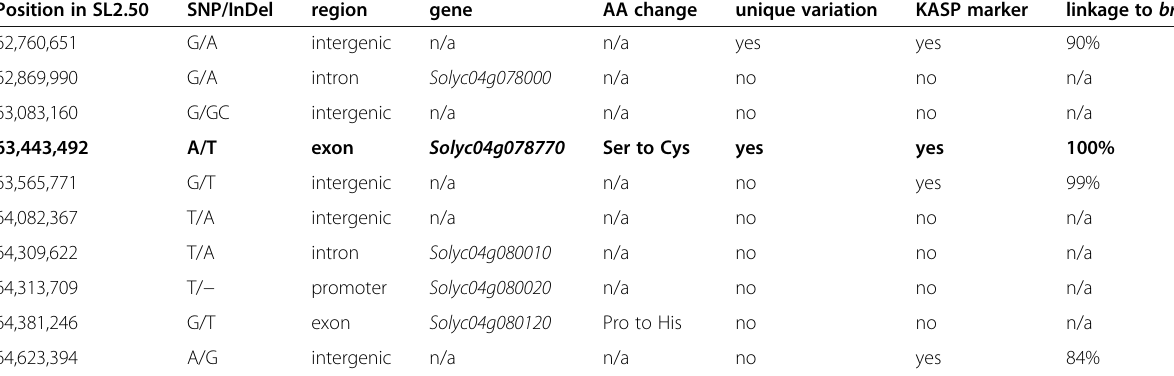
Table 2 Sequence variations in brt-2 compared to other tomato species in the 1.9 Mbp mapping region Position in